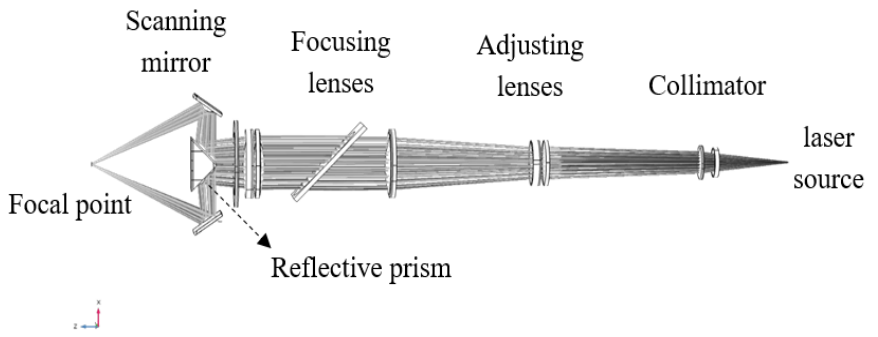
Figure 2. Optical delivery path design.